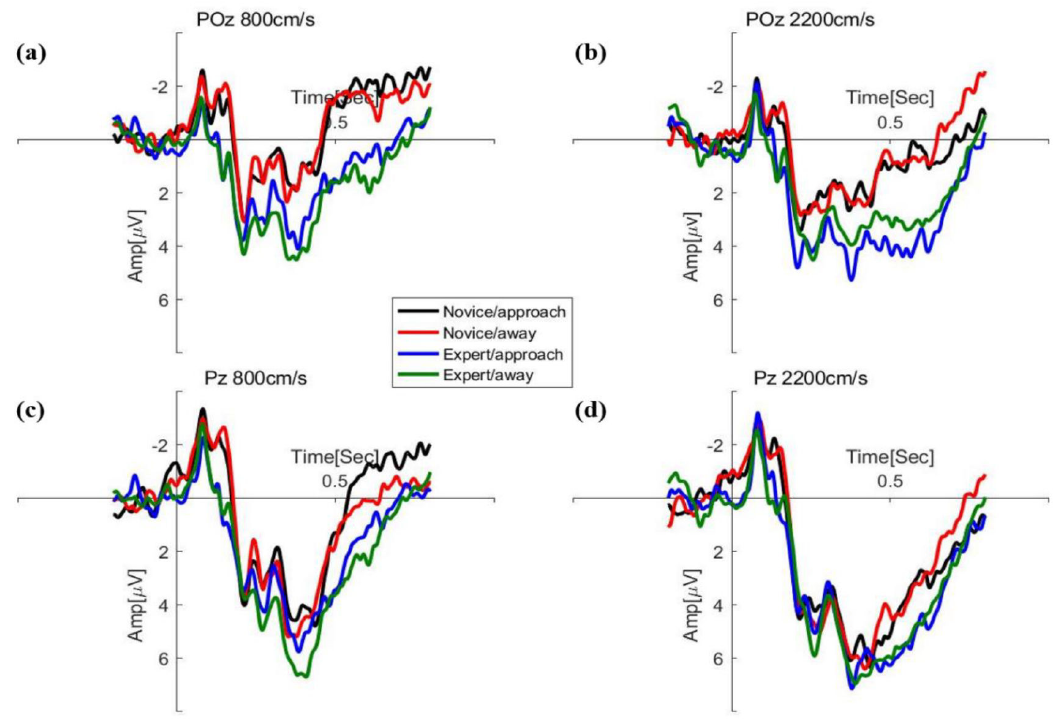
Figure 6. The grand–average waveform for expert and novice at speeds of 800 cm/s ( a , c ) and 2200 cm/s ( b , d ) in the parieto-occipital